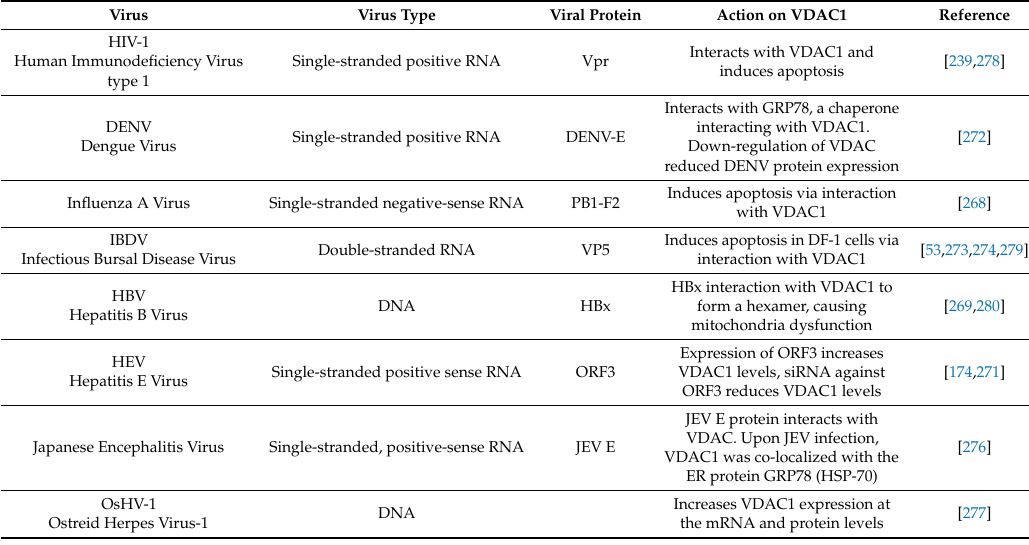
Table 2. Di ff erent viruses target VDAC to modulate mitochondrial activities-VDAC1 is a key protein in the viruses’ e ff ects on the host